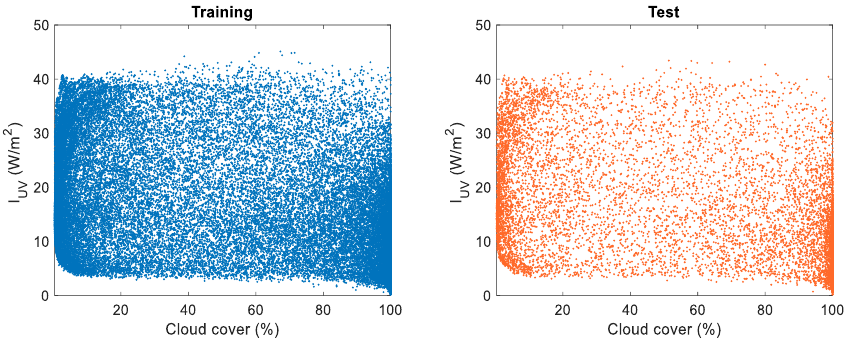
Figure 6. Ultraviolet irradiance, I UV , vs. cloud cover, Cc .